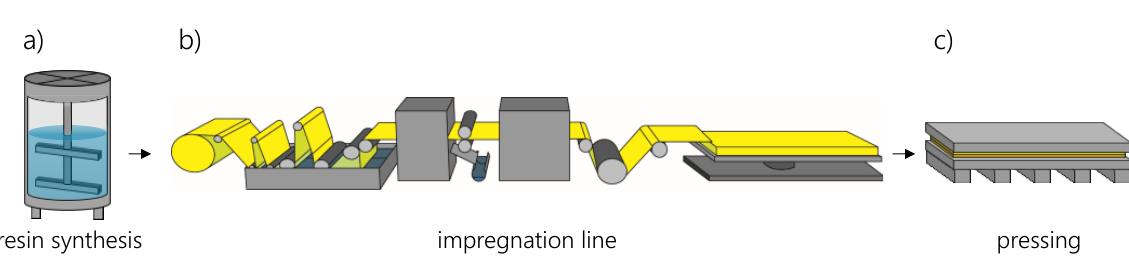
Figure 2. Three-step production process of decorative laminates. ( a ) Resin synthesis. ( b ) Impregna-tion line. ( c ) Pressing of the impregnated paper on a substrate (e.g., particle board). In the first step, the impregnating resin is synthesized. In the subsequent impregnation channel, raw paper is passed through the impregnating resin bath and then dried. In the third step, the dry impregnated paper is processed on a substrate material.